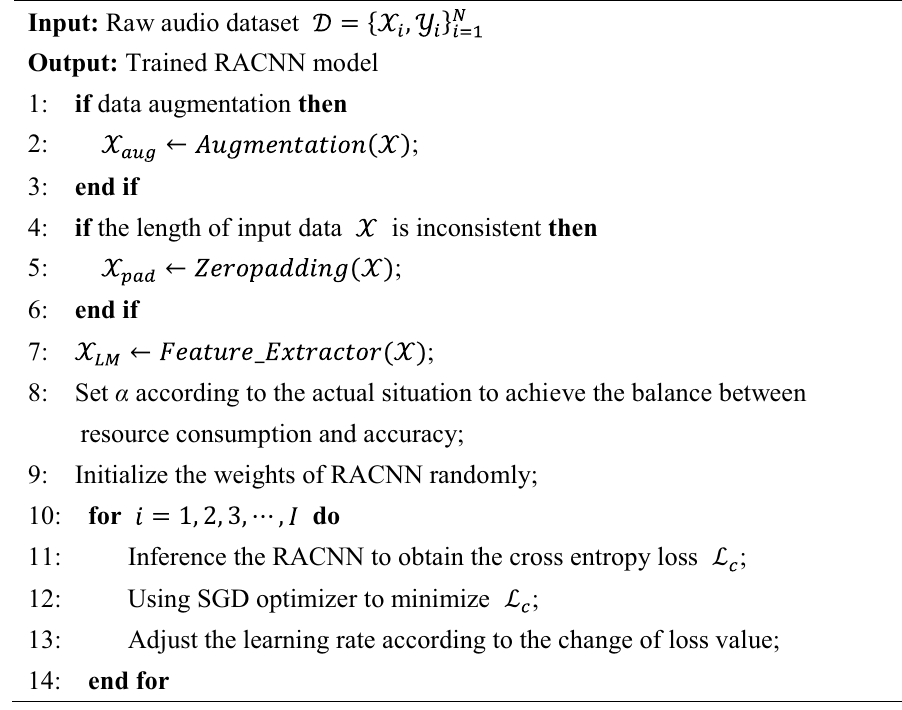
Algorithm1 The pseudo-code for ESC framework using